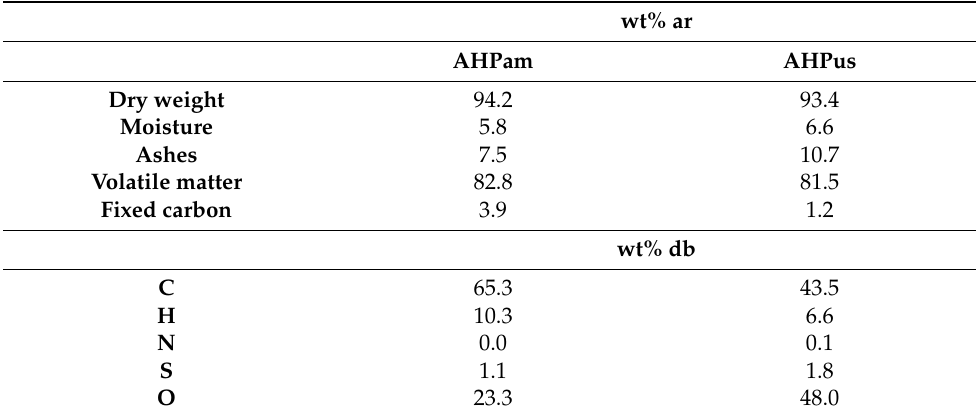
Table 3. Proximate and ultimate analyses of AHPam and AHPus (wt% ar = weight percent on as-received basis; wt% db = weight percent on dry basis).